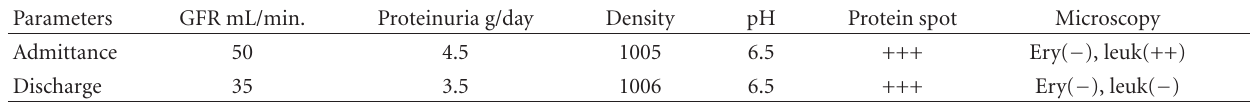
Table 2: The patient’s GFR, proteinuria per day, and complete urine test